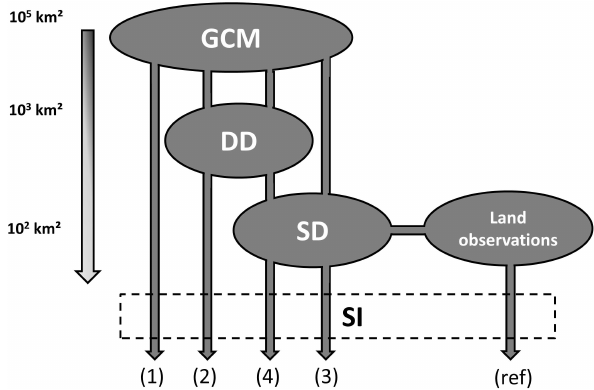
Fig. 1. Methodological framework representing the adopted meth- ods of data processing. The arrows indicate the data fluxes, while models (GCM and relevant downscaling) and land observations are shown with ellipses. The Statistical Interpolation (SI) is rep- resented by a dashed rectangle. Data processing resulting from the data flux are referred as: (1) GCM; (2) DD applied to GCM; (3) SD applied directly to the GCM; (4) SD applied to the DD of the GCM; (ref) land observations. The spatial scale associated with each model is reported on the